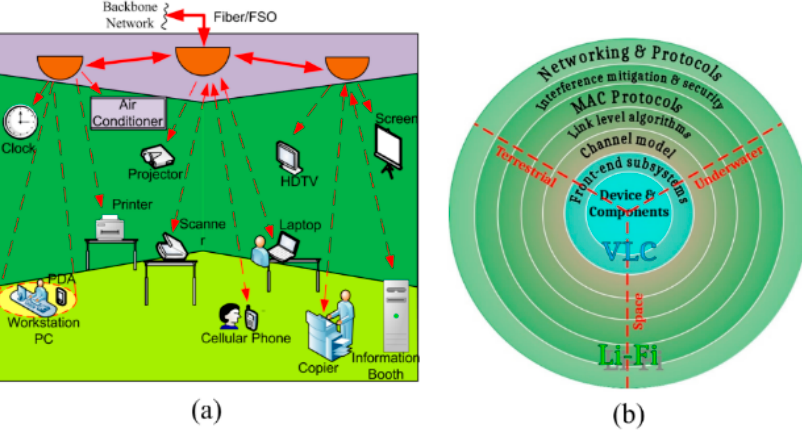
Figure 33. ( a ) Illustration of a Li-Fi indoor network; and ( b ) Li-Fi fundamental sectional blocks. Advanced transmission schemes of Li-Fi systems address improved resource alloca- tion, spatial dimension, cell densification, and channel aggregation for enhanced spectral efficiency. The most effective approach among these techniques is cell densification [254]. Due to the short transmit–receive distance, and small/low-powered cells (Femto-cell/a tt o- cell), Li-Fi can achieve a higher SNR and signi fi cantly extend a handset’s ba tt ery life. As a